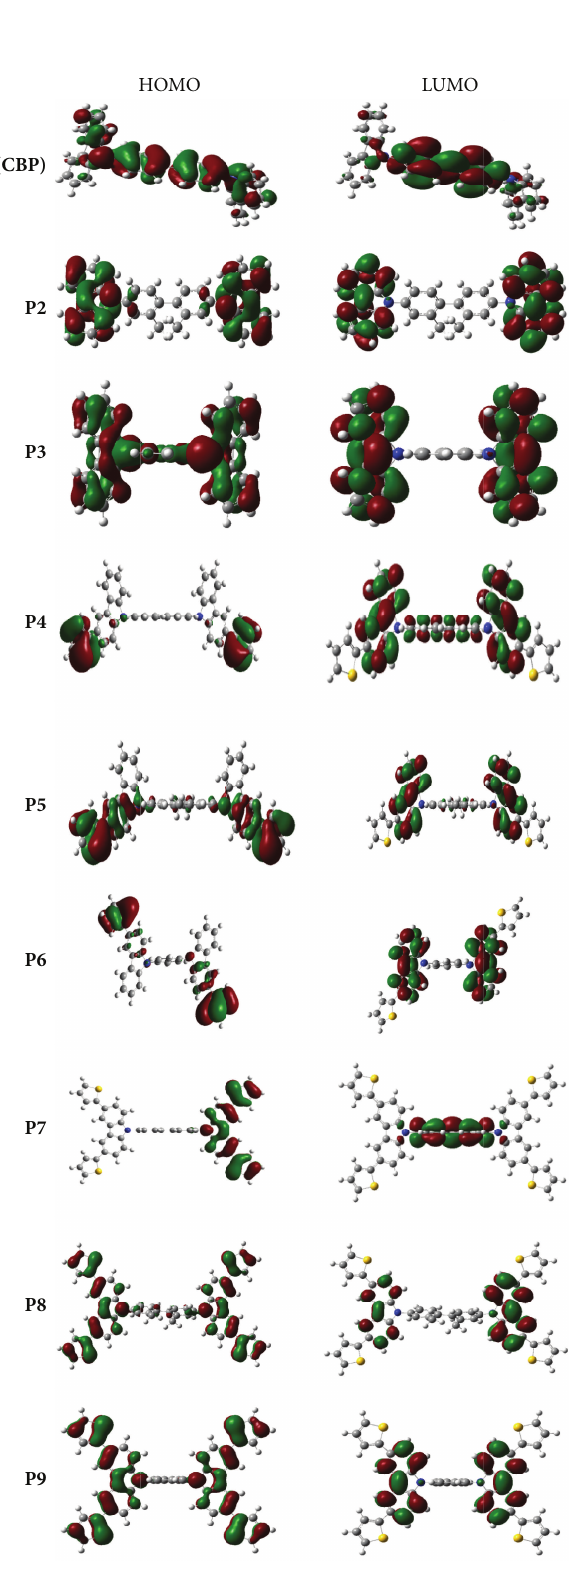
Figure 7: HOMO and LUMO frontier molecular orbitals of compounds P1–P9 that were calculated in vacuo at B3LYP/6-31G level of